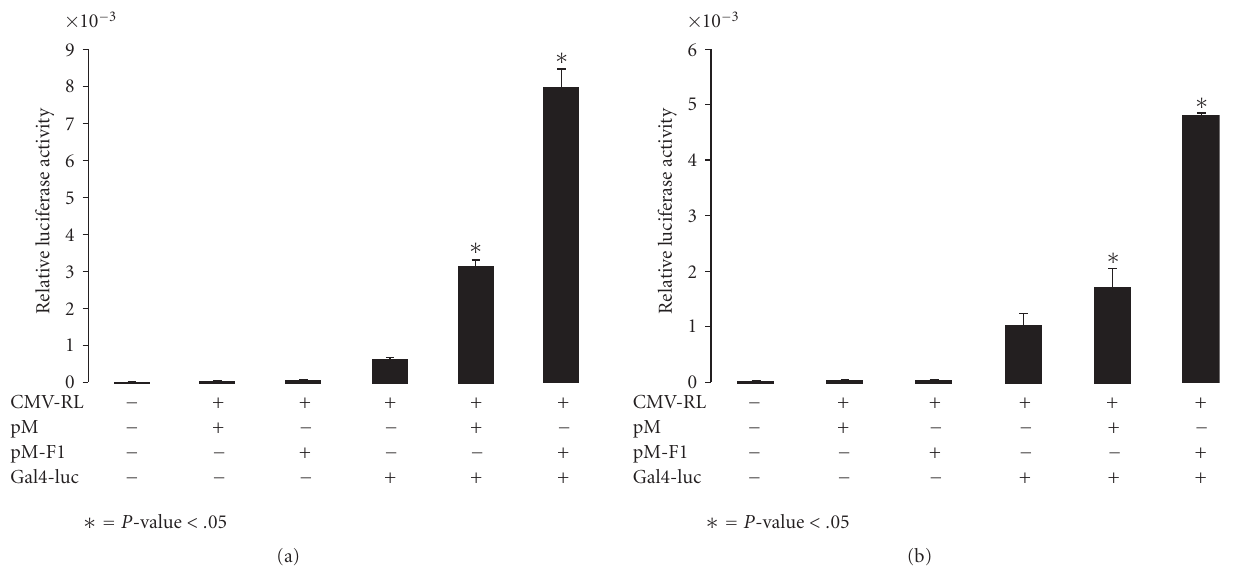
Figure 6: PRIC295 functions as a coactivator protein in Gal4-binding assay. Transfection of chimeric Gal4-DBD-PRIC295-F1(E) or Gal4- DBD-PRIC295-F2(F) significantly enhanced transcription of the luciferase reporter gene. Transfection of chimeric Gal4-DBD-PRIC295-F3 did not significantly enhance the transcription of the luciferase reporter (F3; not illustrated). HeLa cells were transfected with 100 ng of pM- Δ PRIC295 1–915 (F1) (a), pM- Δ PRIC295 840–1815 (F2) (b), Gal4-TK-Luc and 50 ng of CMV-RL as indicated (+ or − ). Each column shown is the mean relative luciferase unit value for triplicate experiments. Statistical significance was calculated by comparison of transfected groups marked with an ∗